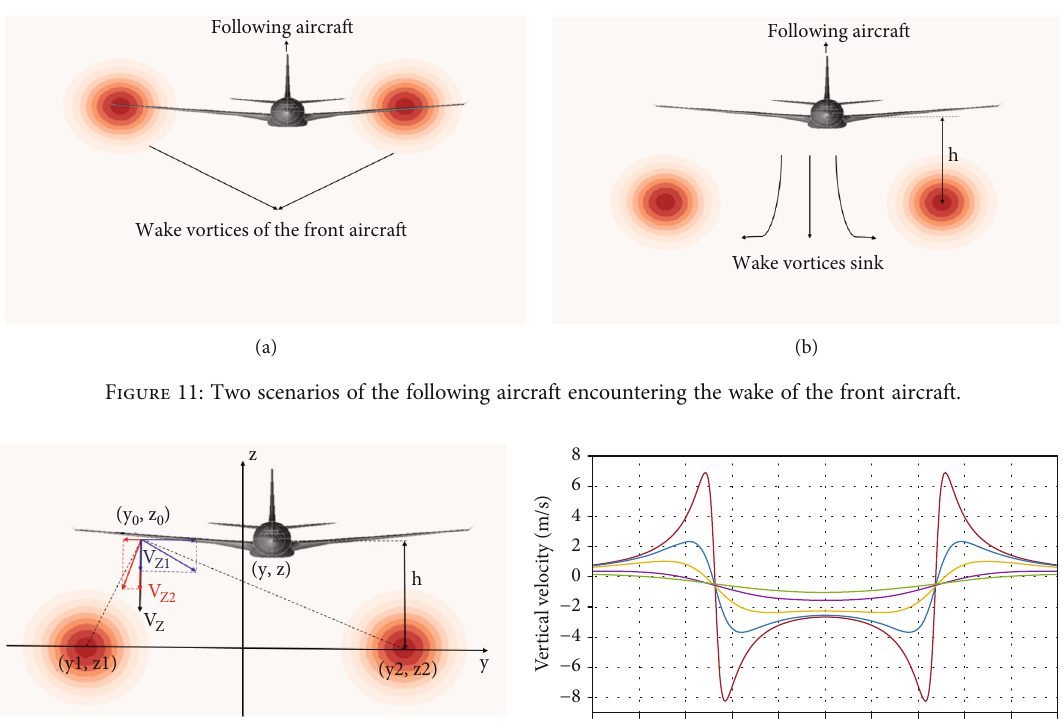
Figure 10: Circulation changes at di ff erent distances from the ground.